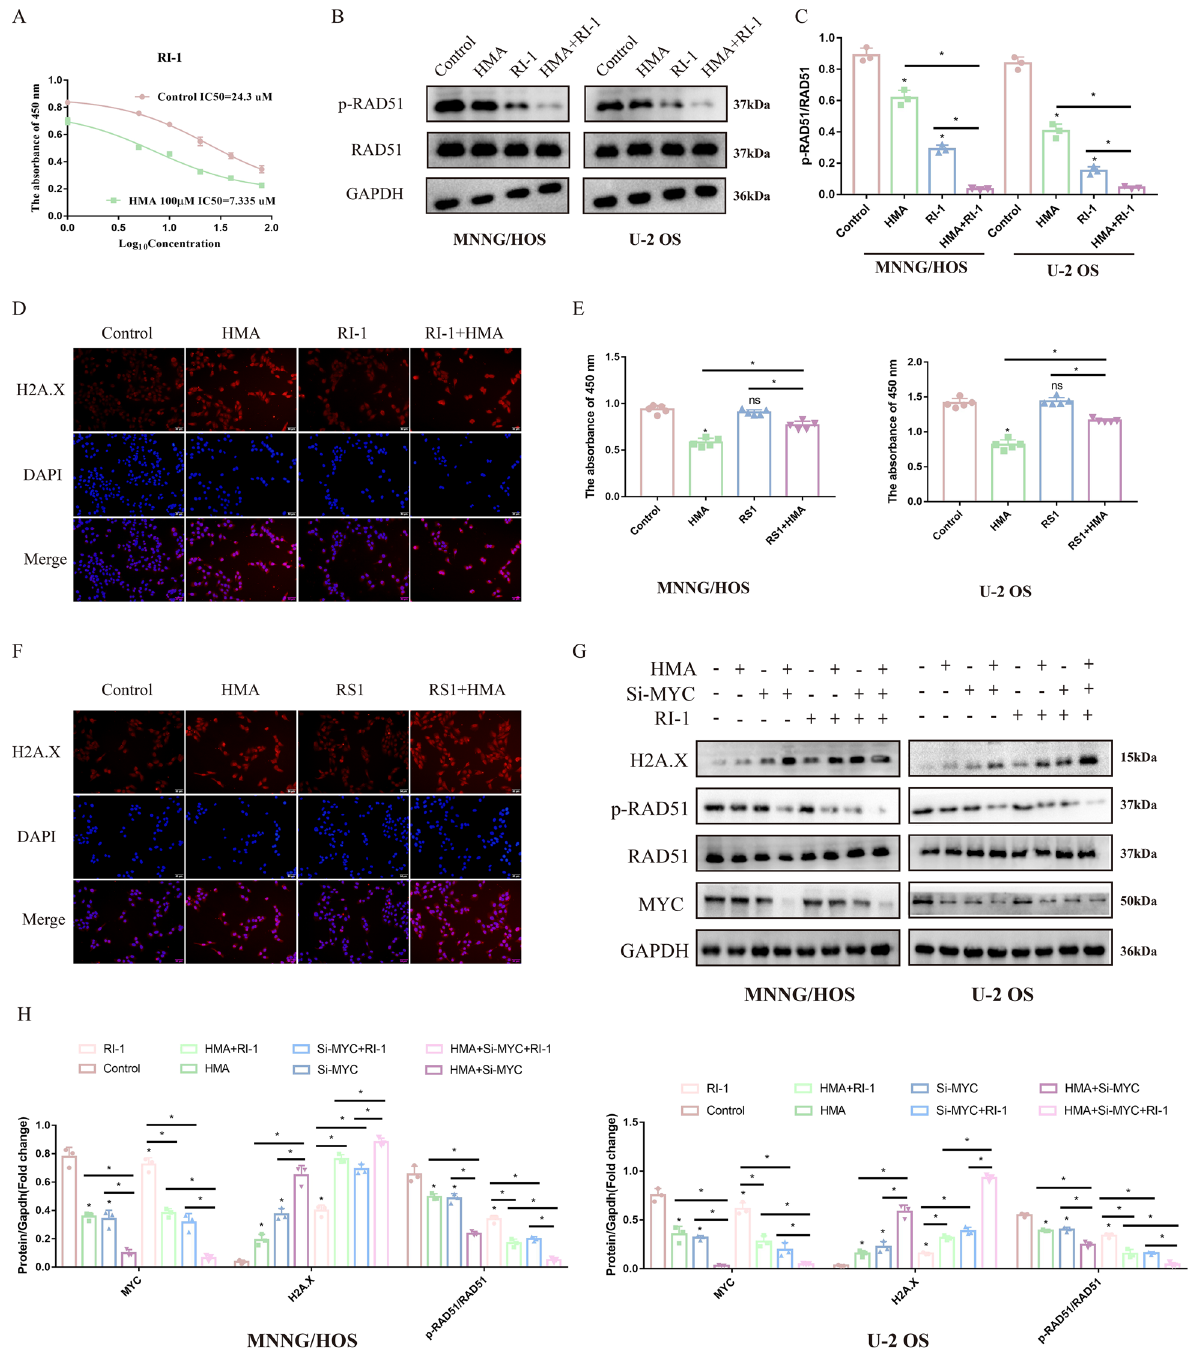
Fig. 4 Impairment of the RAD51-mediated homologous recombination after HMA treatment: A The IC 50 of RI-1 was detected in the MNNG/HOS cells with or without HMA treatment. B , C The expression of RAD51 and p-RAD51 was detected. D The subcellular structural localization of H2A.X was detected using immunofluorescence after RI-1 and HMA treatment. After treatment with RS-1 and HMA, the cells were analyzed using E CCK-8 assay and F H2A.X immunofluorescence. G , H Rescue assays show the relationship between HMA, MYC, and